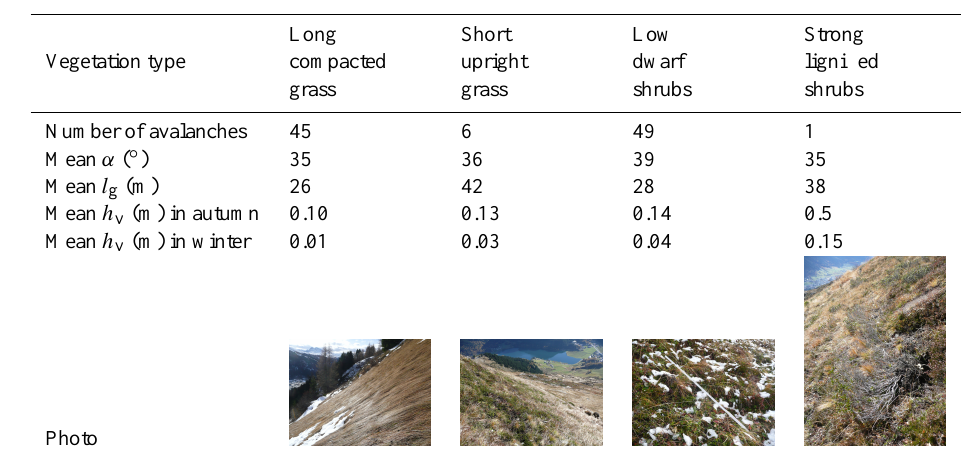
Table 1. The observed vegetation types on the Dorfberg. Mean vegetation height h v in autumn and winter, slope angle α , slab length l g and a photo of a typical example case are